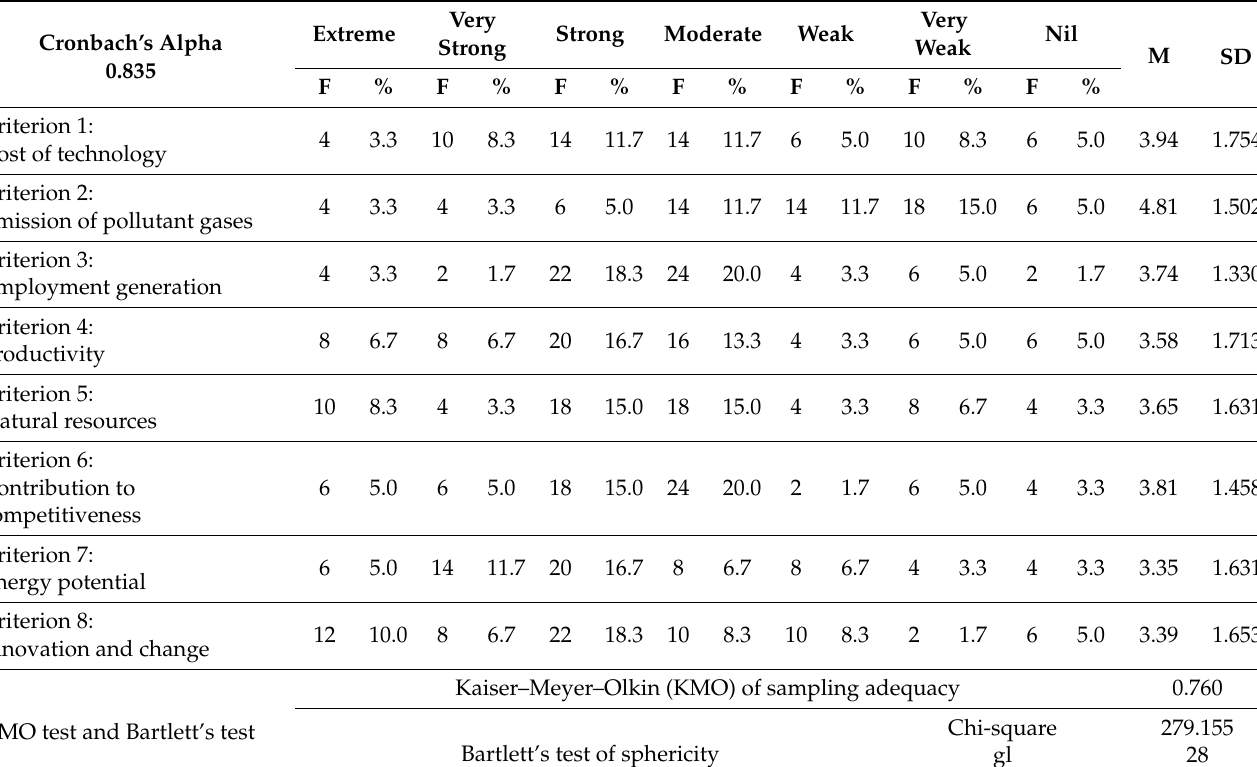
Table 16. Evaluation of the attractiveness of H-Bio.